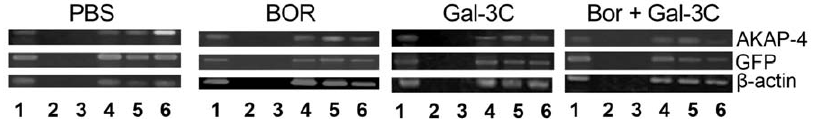
Figure 8. Analysis of AKAP-4 and GFP expression. RT-PCR showing the expression of AKAP-4 and GFP in the tumor masses in the four groups (5 mice/group): (1) U266 (2) no RT (3) no template (4) d 21 (5) d 28 (6) d 35. The U266 cell line was used as a positive control after culture for 48-h.